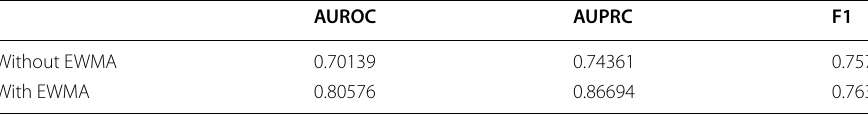
Table 4 Experiments to compare smoothing performance AUROC AUPRC F1 Without EWMA 0.70139 0.74361 0.75755 With EWMA 0.80576 0.86694